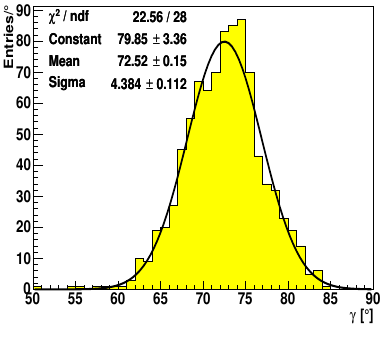
Figure 12 . (cid:13) sensitivity with 50 ab (cid:0) 1 Belle II